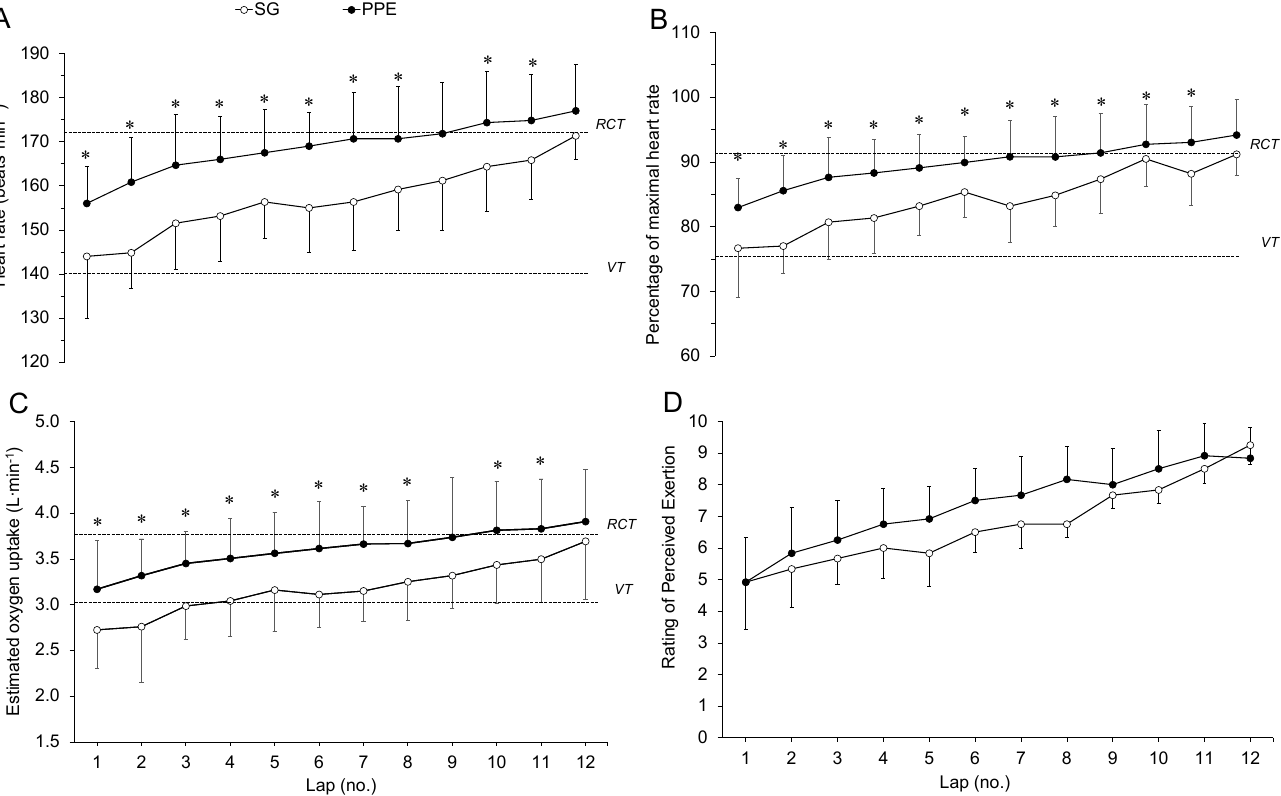
Figure 2. Heart rate ( A , B ), estimated VO 2 ( C ) and rating of perceived exertion ( D ) throughout the Pack Test wearing traditional short sports gear (SG) and a wildland firefighters’ personal protective equipment (PPE). RCT, respiratory compensation threshold; VT, ventilatory threshold. Values are mean ± SD. * indicates significant difference ( p < 0.05).